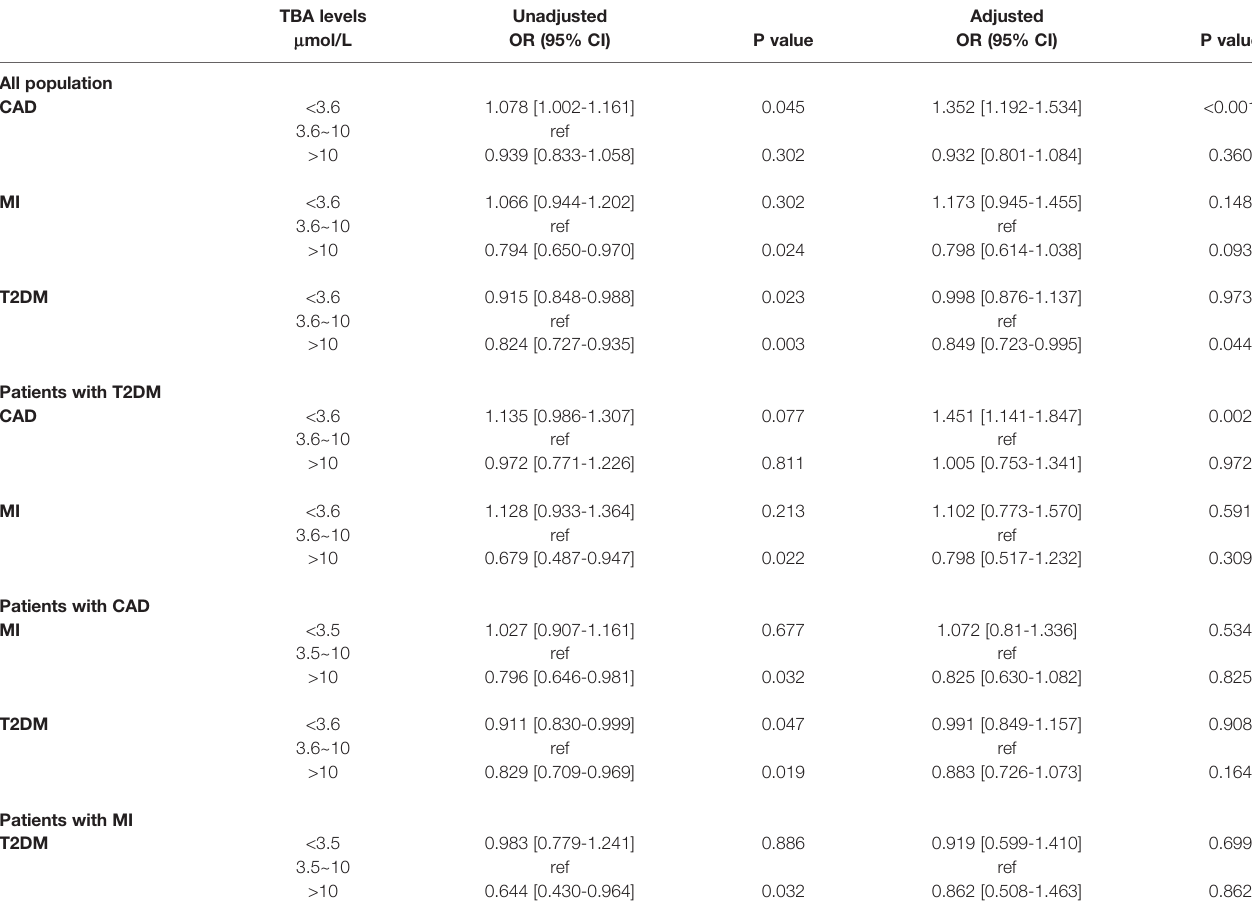
TABLE 5 | Odds ratios of CAD, MI, T2DM and CAD/MI combined with T2DM in relation to the TBA